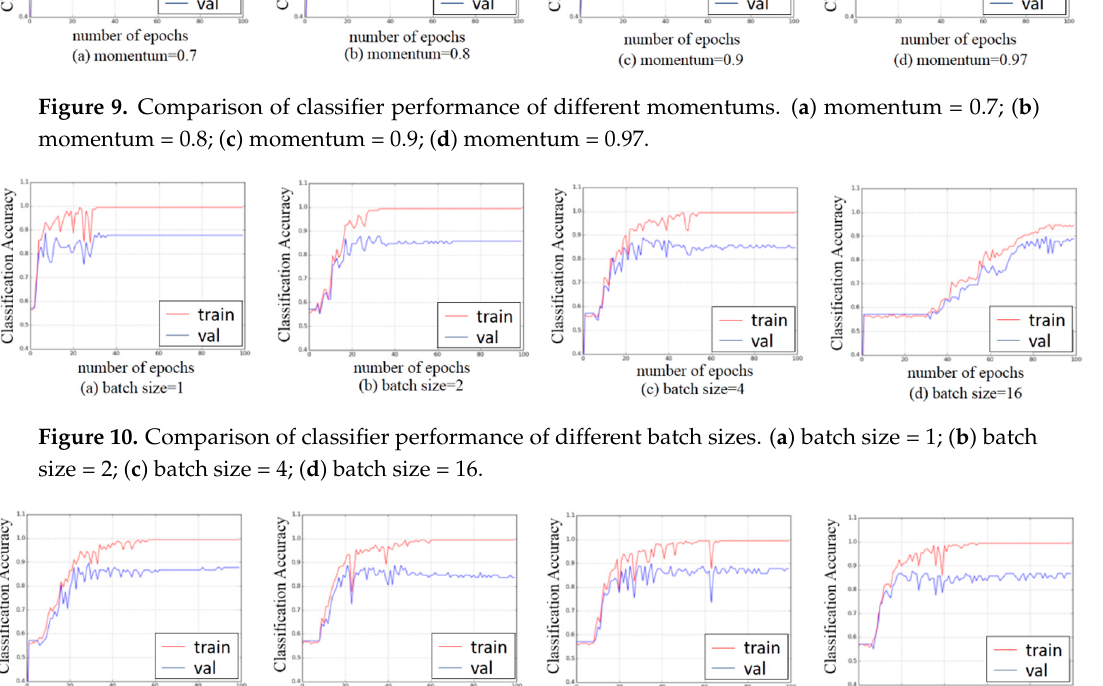
Figure 9. Comparison of classifier performance of different momentums. ( a ) momentum=0.7; ( b ) momentum=0.8; ( c ) momentum=0.9; ( d ) momentum=0.97.